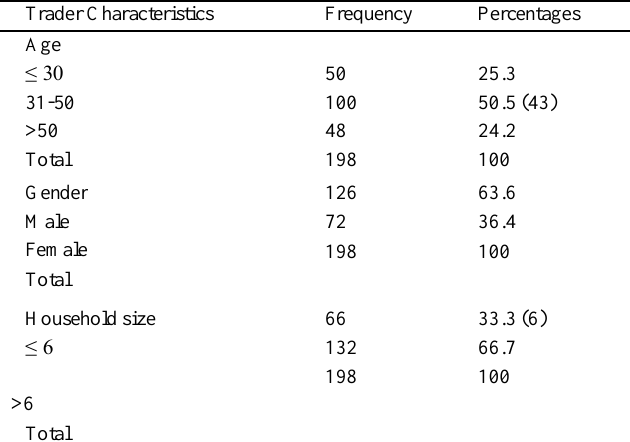
Table 1: Traders Characteristics of Respondents